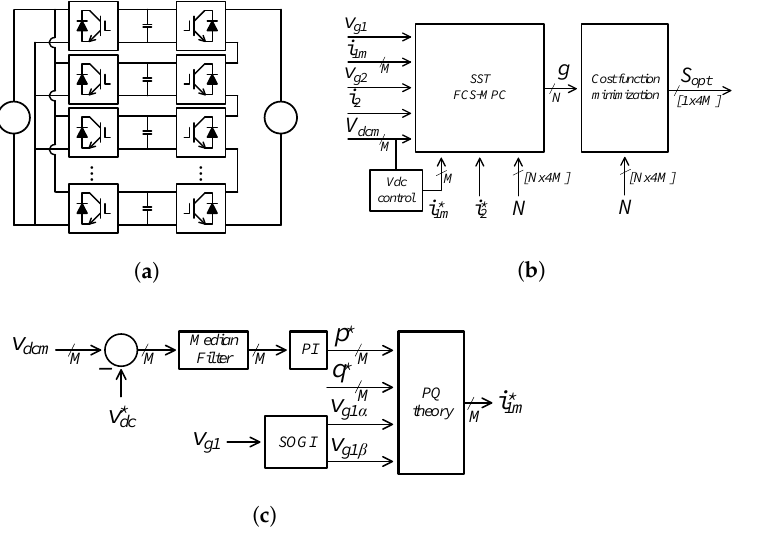
Figure 14. Generic M -modules IPOS CHB-B2B converter: ( a ) topology configuration, ( b ) MPC diagram block, ( c ) primary side currents references